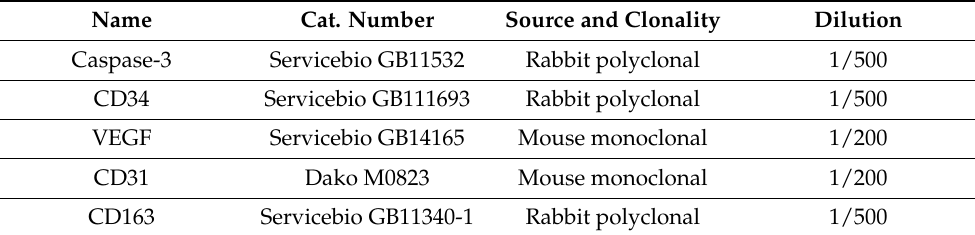
Table 3. The primary antibodies applied for